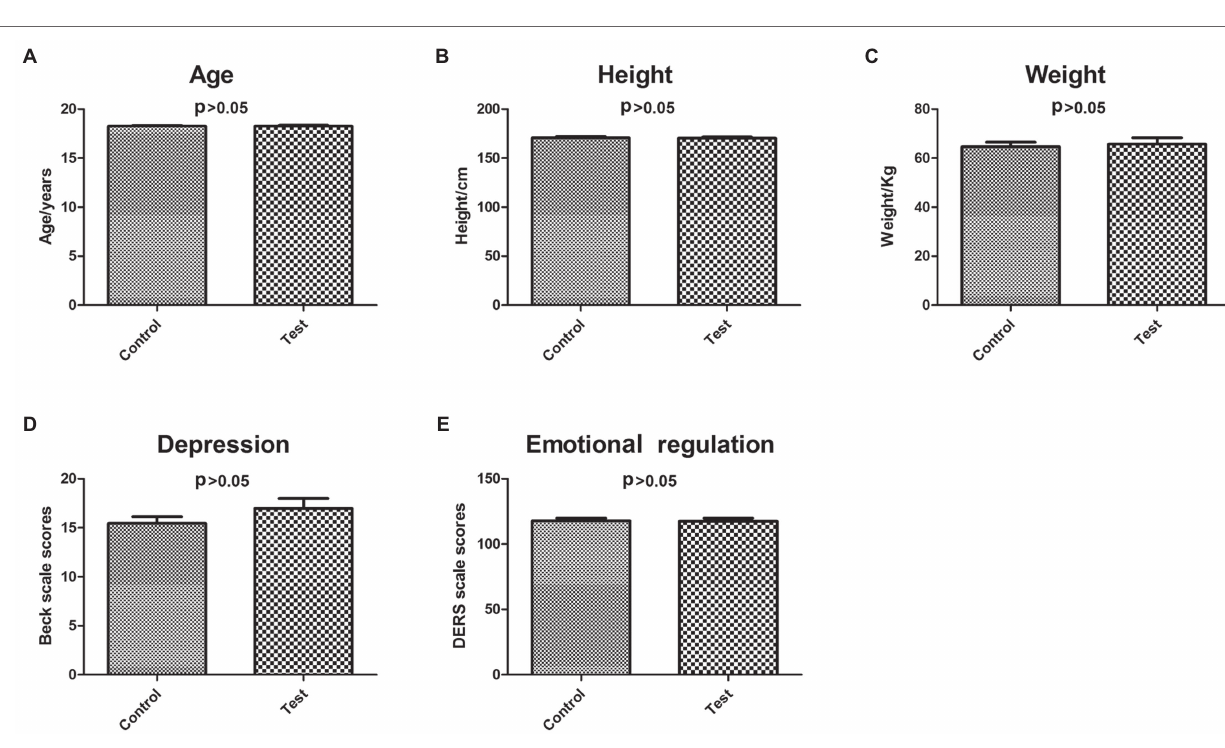
FIGURE 2 | Characterization of control and experimental subjects. The differences between control and experimental subjects in age (A) , height (B) , weight (C) , depression (D) , and emotional regulation (E)